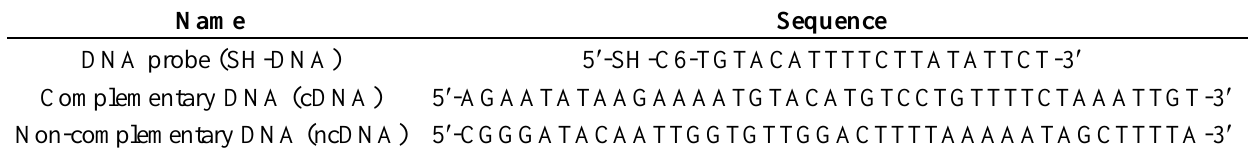
Table 1. Details of the DNA sequences used in the DNA